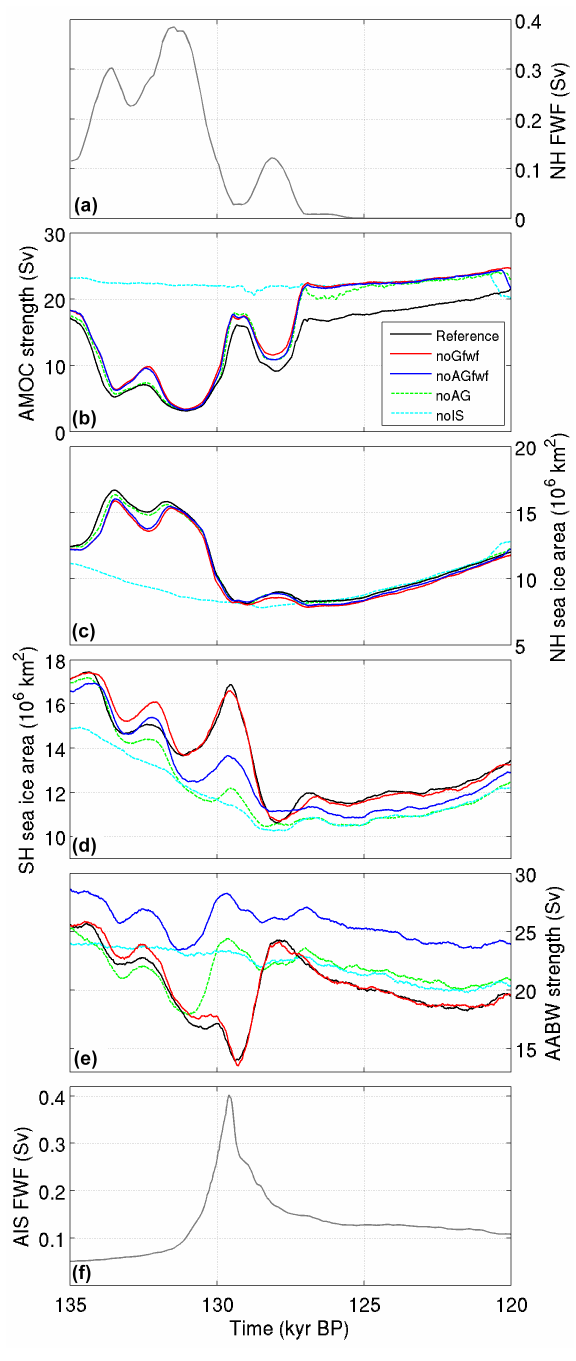
Figure 7. Freshwater forcing and oceanic response characteristics. NH (a) and Antarctic ice sheet freshwater fluxes (f) , strength of the AMOC (b) , NH sea ice area (c) , SH sea ice area (d) , and strength of AABW formation (e) for the different experiments with and with- out freshwater forcing from Greenland, Antarctic, and NH ice sheet melting. Curves are smoothed with a running mean of 200 years for better